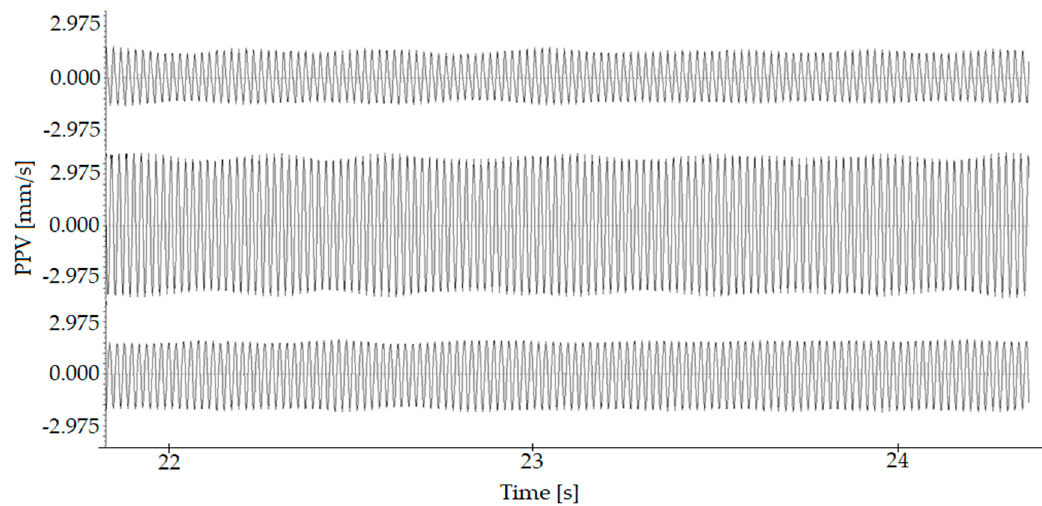
Figure 5. Example of a wave pattern record of vibrated gravel piles.